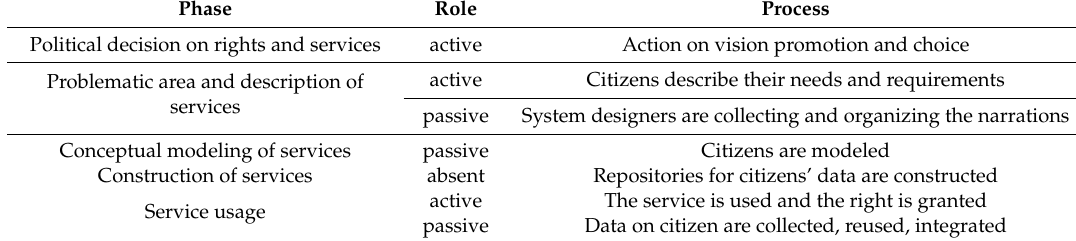
Figure 1. Natural language in the information system ‐ developing scheme. With red borders are all of the phases affected by natural language.